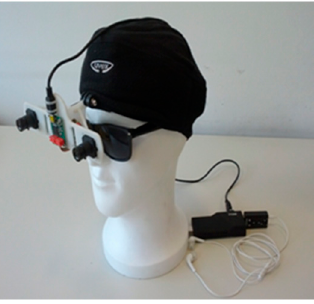
Figure 36. The proposed system to be mounted on the head [56].